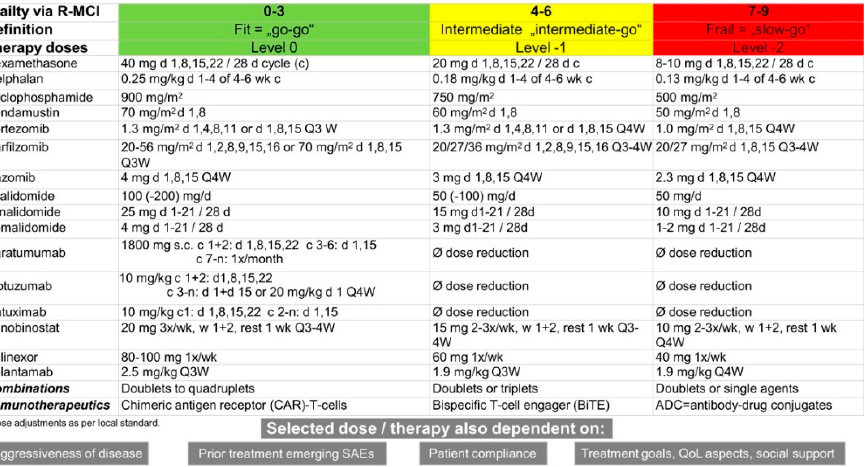
Figure 4. Dose adjustments regarding anti-MM therapy agents according to R-MCI. MM typically affects the elderly, this cohort of patients itself being very heterogeneous. Geriatric assessments such as the R-MCI or IMWG frailty index do not only show overt comorbidities but also display the level of frailty, which helps guide the process of decision making regarding each patient’s vulnerability. More precisely, the R-MCI is a validated and prospectively assessed comorbidity index, which groups patients into fit, intermediate and frail resulting in different PFS and OS for these patients. Consequently, treatment regimens and dosing of substances needs to be adapted according to the grade of frailty by R-MCI to prevent the overtreatment of frail patients and the undertreatment of fit patients. Abbreviations: c = cycle, d = day, Q3W = every 3 weeks, QoL = quality of life, R-MCI = revised myeloma comorbidity index, SAEs = serious adverse events, wk = week.